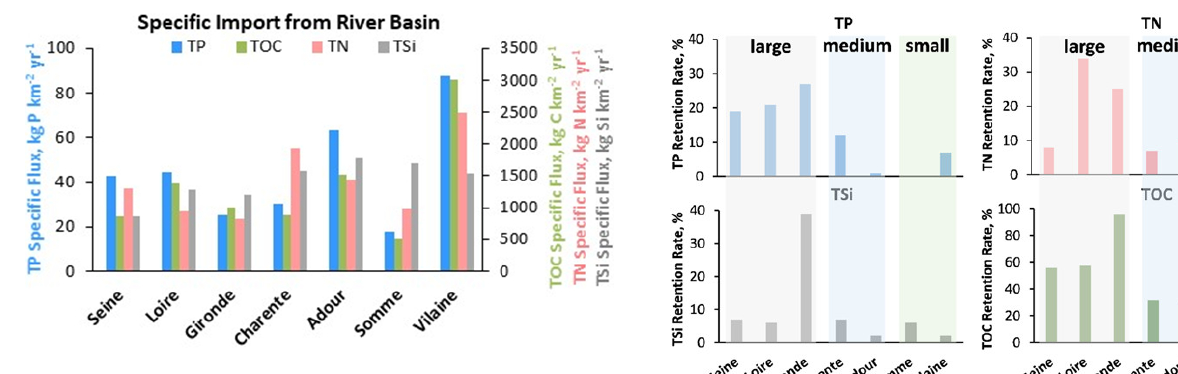
Figure 5. Average annual (2014–2016) specific fluxes of total phos- phorus (TP), nitrogen (TN), organic carbon (TOC), and silica (TSi) entering the estuaries studied. Figure 6. Annual mean (2014–2016) retention rates for the seven estuaries studied in terms of total phosphorus (TP), nitrogen (TN), organic carbon (TOC), and silica